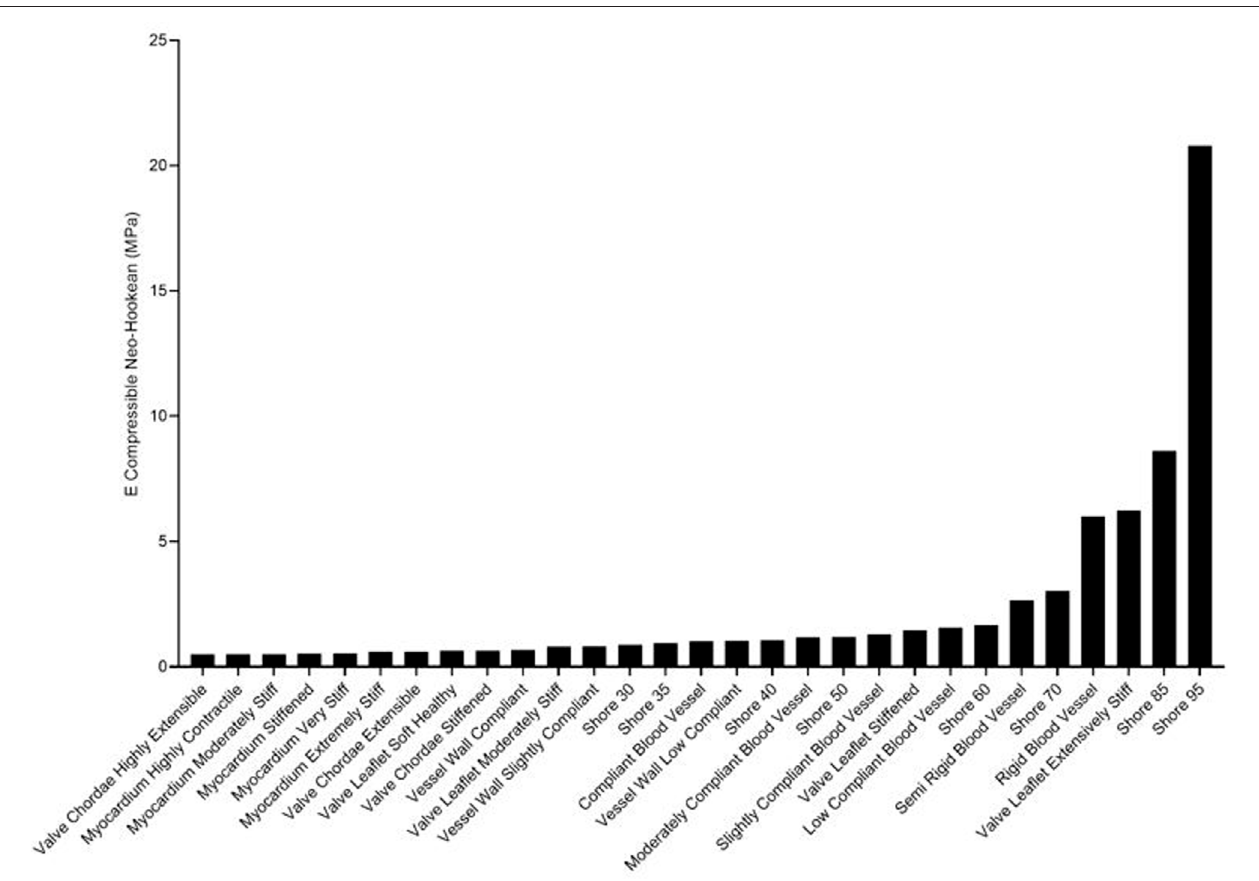
FIGURE 4 | Ranking of J750 3D printed Shore, the DAP blood vessel materials, and the DAP structural heart materials for the elastic modulus of the compressible nonlinear strain energy function of Eq. 6a .